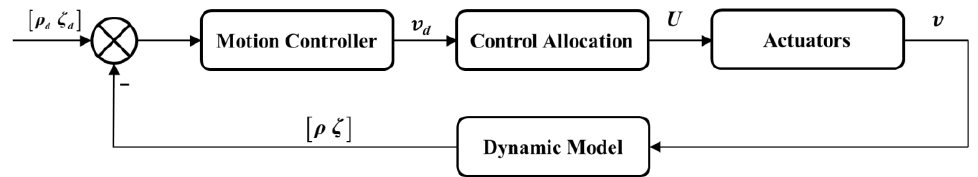
Figure 3. Structure of control systems with redundant actuators.